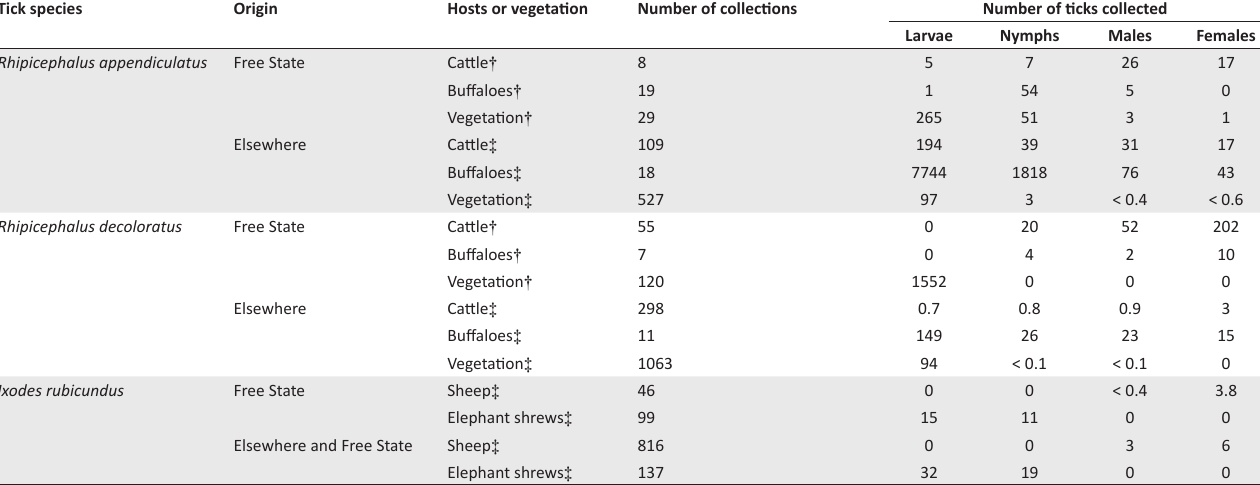
FIGURE 1: Sampling localities at which ticks were collected in Free State Province, South Africa. TABLE 1: Major tick species endemic to Free State Province, South Africa and their hosts. Tick